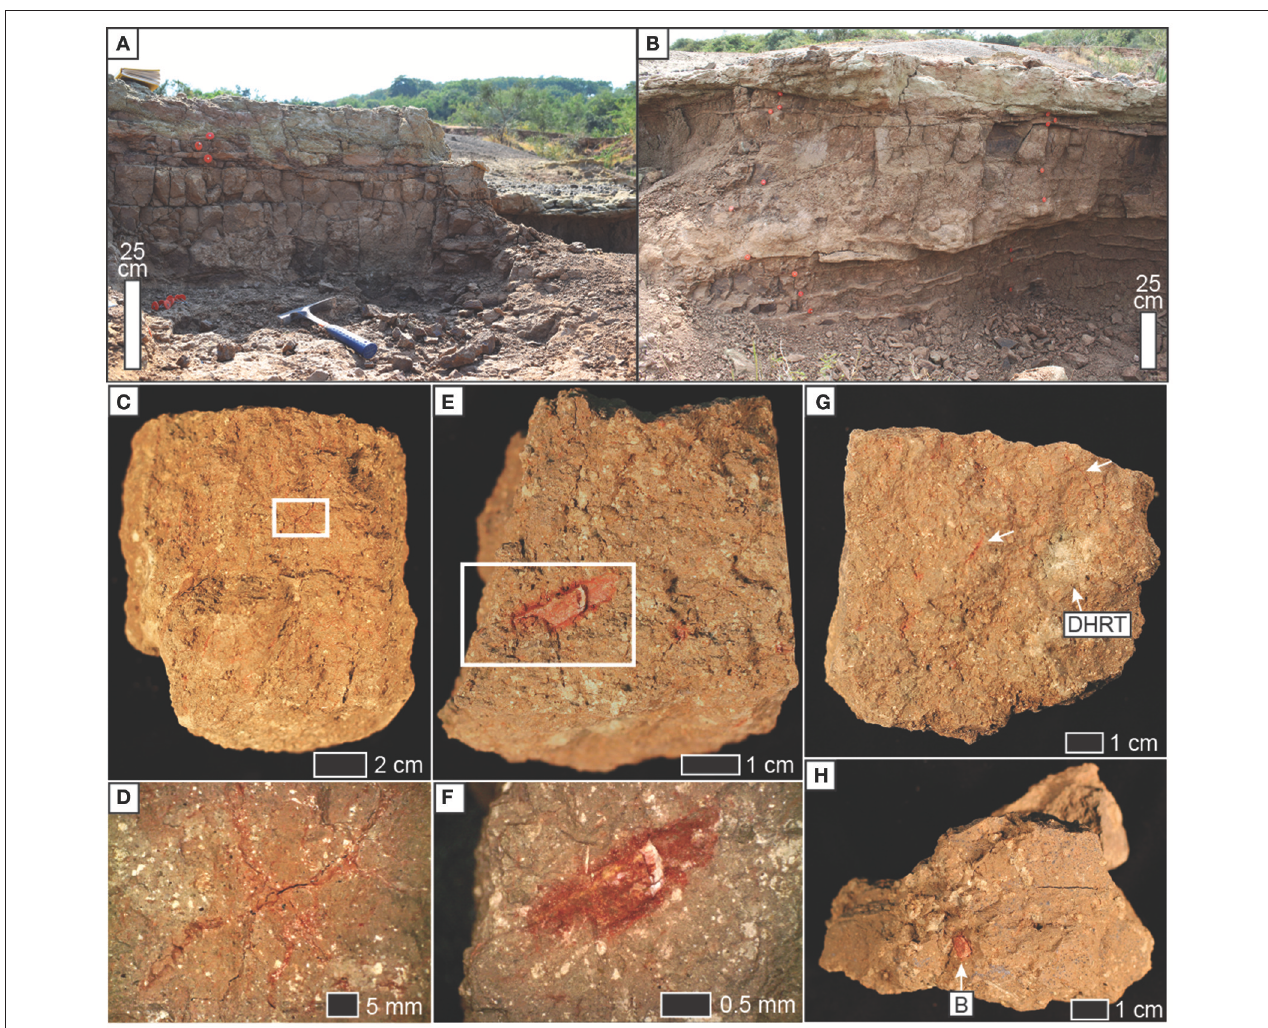
FIGURE 4 | Field photographs of profiles of (A) NG15-A and (B) NG15-B. Note prismatic ped structure in 2Btk horizon. (C) Prismatic ped from 2Btk horizon (vertically oriented). Thin, red lines are root traces lined with Fe and clay; white speckles are pedogenic carbonates. (D) Close-up of thin root traces from white box in (C) . Photo taken with reflected light and a polarizing filter. (E) Angular blocky compound ped removed from a prismatic ped in the 2Btk horizon. Photo is the base of the ped, with Fe-coated microvertebrate fossil. (F) Close-up of microvertebrate bone from E. Note Fe coating and white pedogenic carbonate. Faint, thin root traces are also present. Photo taken with reflected light and a polarizing filter. (G) Angular blocky ped from 2Btk horizon. White arrows indicate fine root traces; DHRT = drab halo root trace. Ped is vertically oriented. (H) Base of an irregular angular blocky ped (3Bw horizon), with Fe-stained bone fragment indicated. Note white calcareous rhizoliths, seen in cross section from this view. Photo in box A is used with permission from T.